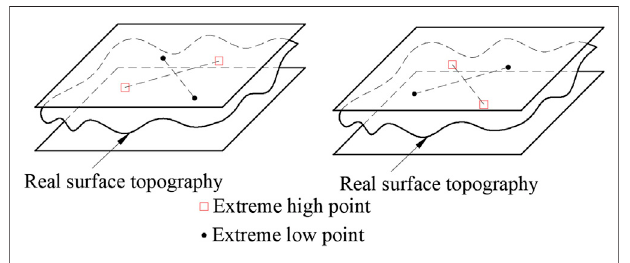
FIGURE 9 | Cross criteria.